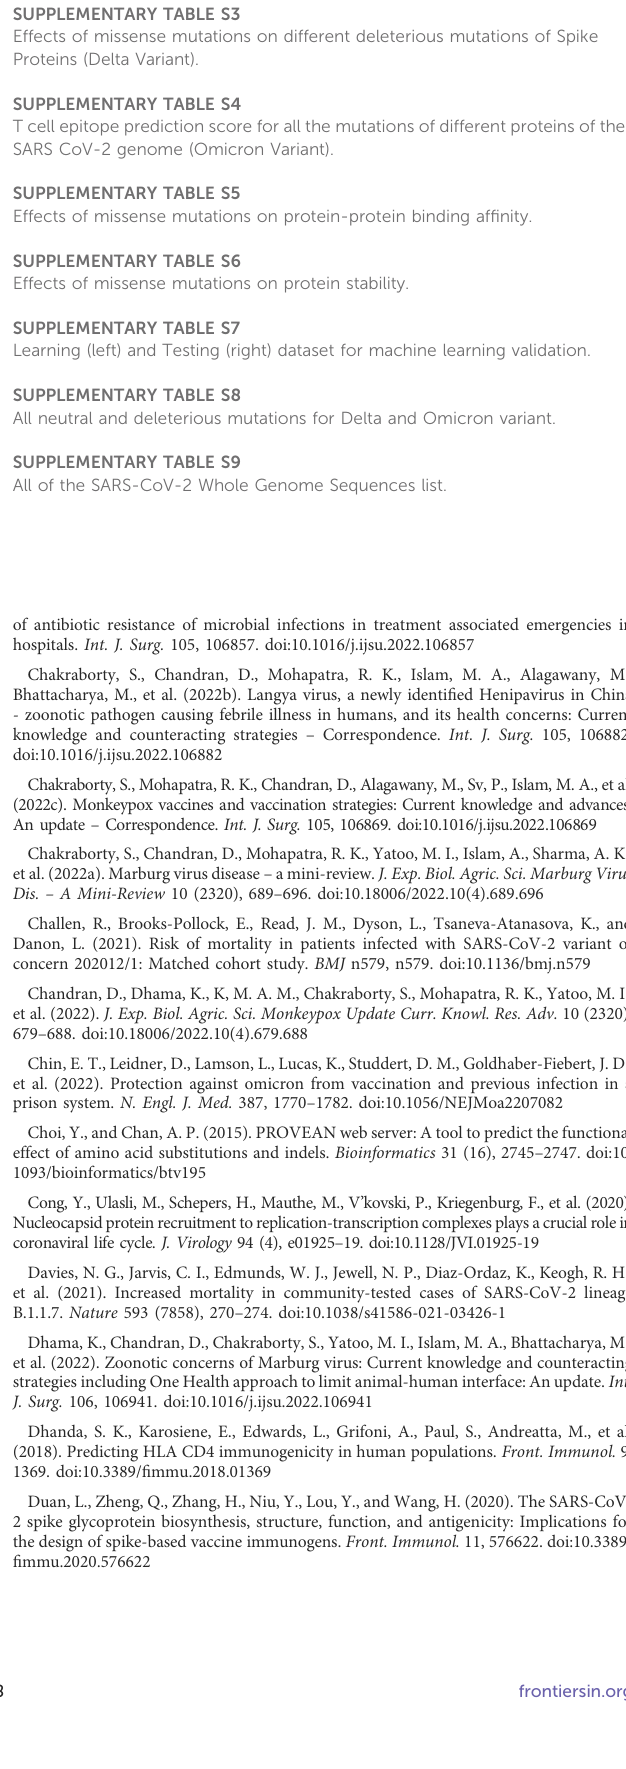
SUPPLEMENTARY TABLE S3 Effects of missense mutations on different deleterious mutations of Spike